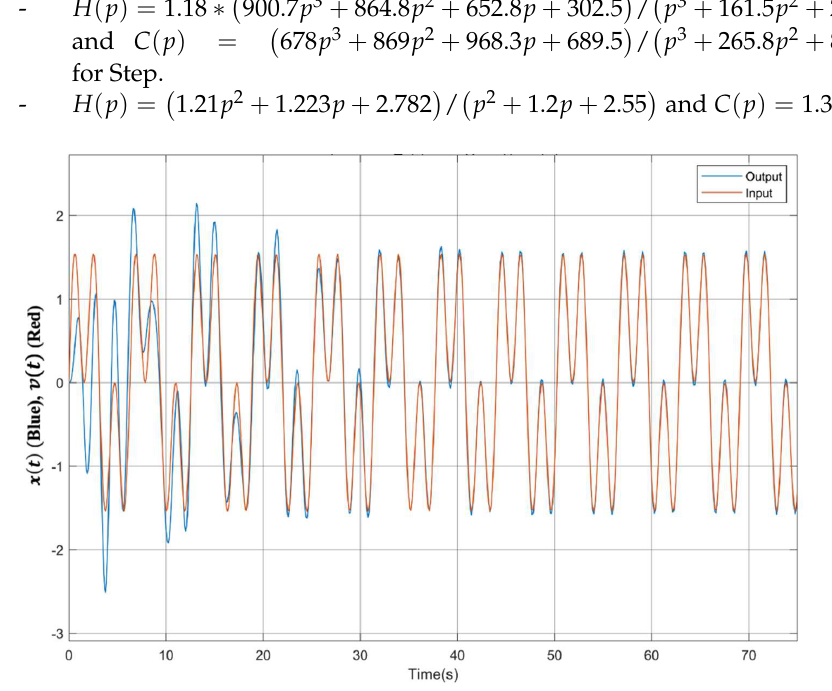
Figure 4. Response to the Periodic Input v ( t ) = sin t + sin3 t with Technique 1. Simulation Results: Figures 5 and 6 show responses to step and periodic inputs in the new coordinate x 0.5 ( t ) , defined as the state that corresponds to the plant ( C ( p ) G ( p )) / ( 1 + C ( p ) G ( p ) H ( p )) . The response in Figure 5 (Figure 6) takes about